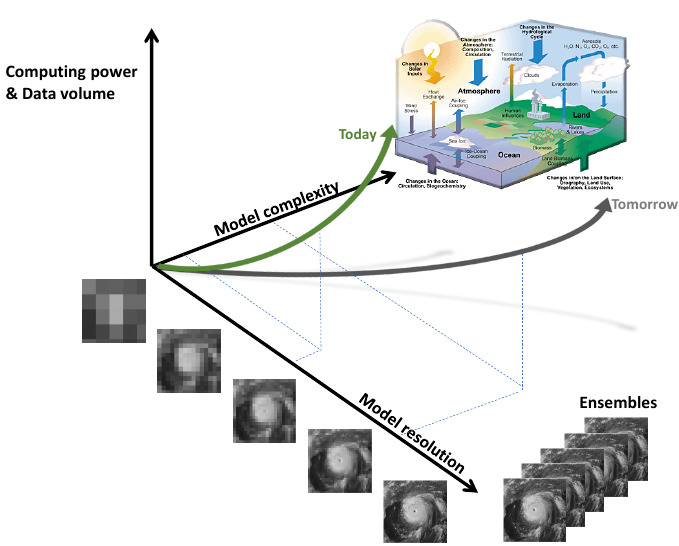
Figure 27. Model complexity, model resolution and ensemble, and High Performance Computing and data volume trade-offs. Courtesy of Peter Bauer,